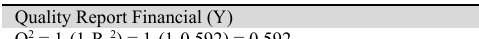
Predictive Relevance Numbers from Q-square Variables